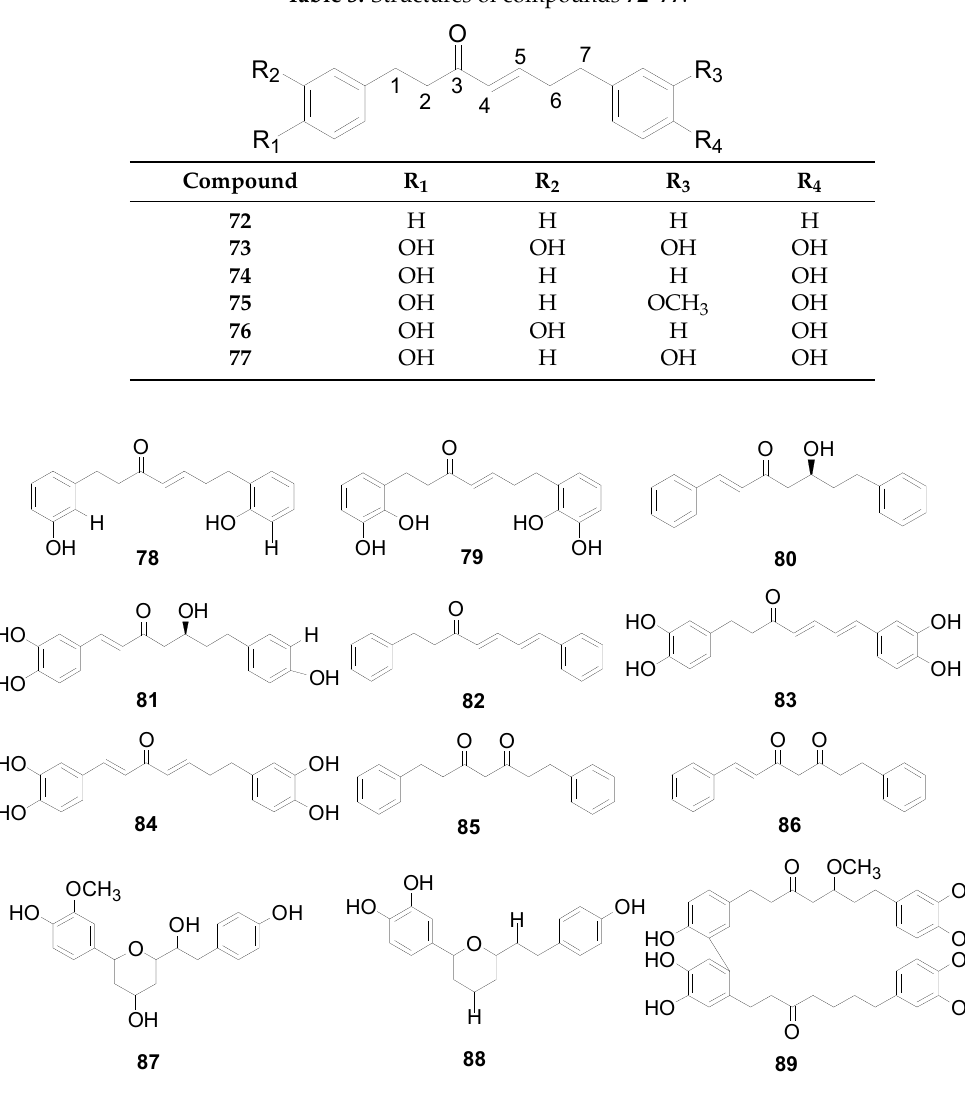
Figure 1. Structures of compounds 78 – 89 .